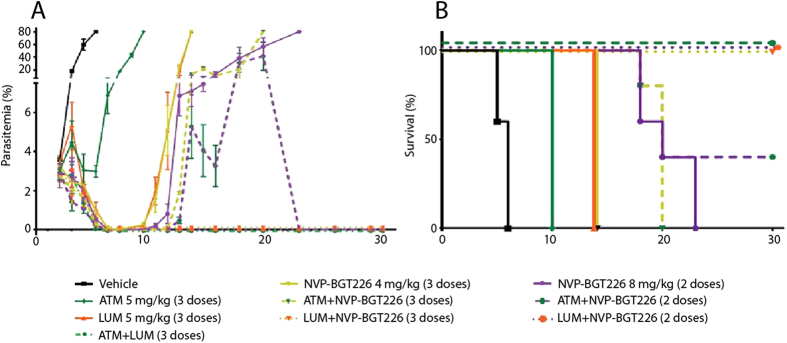
Comparative in vivo activities for Artemether (ATM), Lumefantrine (LUM) and NVP-BGT226 as single agents and in combination.P. berghei infected BALB/c mice were treated with ATM (5 mg/kg), LUM (5 mg/kg), NVP-BGT226 (4 mg/kg), or NVP-BGT226 (8 mg/kg), or combinations thereof as indicated above. (A) Parasitemia values for ATM, LUM and NVP-BGT226 as either single agents or in combination. All treatment was started three days post infection, with doses administered by oral gavage on day 3, 4 and 5 (3 doses) or on days 3 and 4 (2 doses). (B) Survival plot for ATM, LUM and NVP-BGT226 as either single agents or in combination. All mice that survived until day 30 (5/5- ATM/LUM (3 doses); 5/5- LUM/NVP-BGT226 (3 doses); 2/5- ATM/NVP-BGT226 (2 doses); 5/5- LUM/NVP-BGT226 (2 doses)) remained negative for parasites through 60 day post infection follow-up.